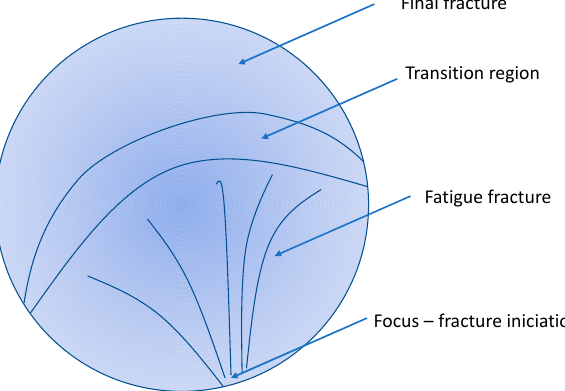
Figure 14. Schematic drawing of the fracture surface showing the observed zones.